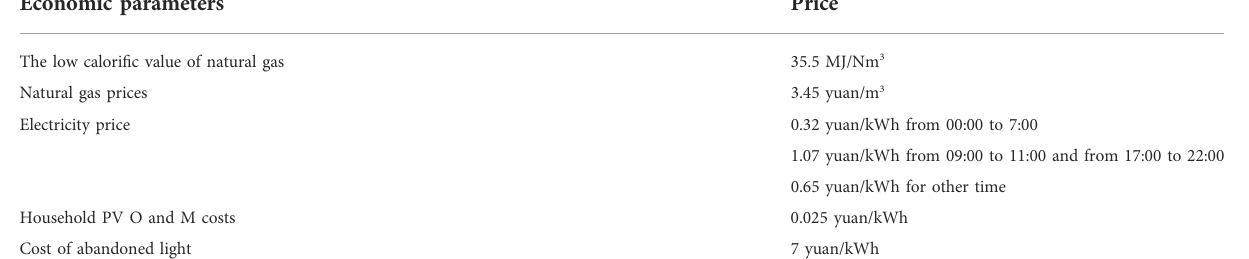
TABLE 2 System economic parameters.